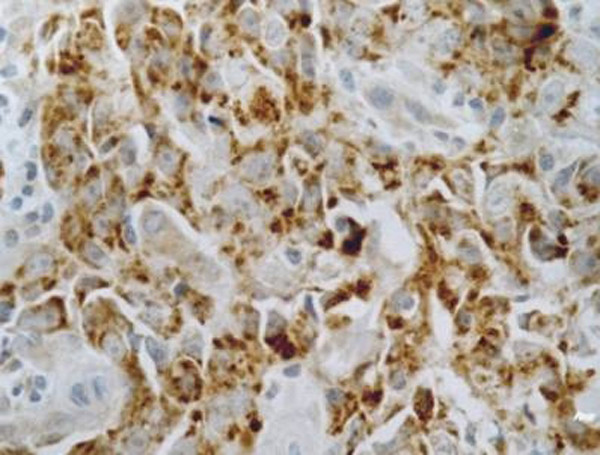
Positive control of the patterns of HIF-1α expression. Samples known to express HIF-1α intensely served as the positive control repoted by Zhong.